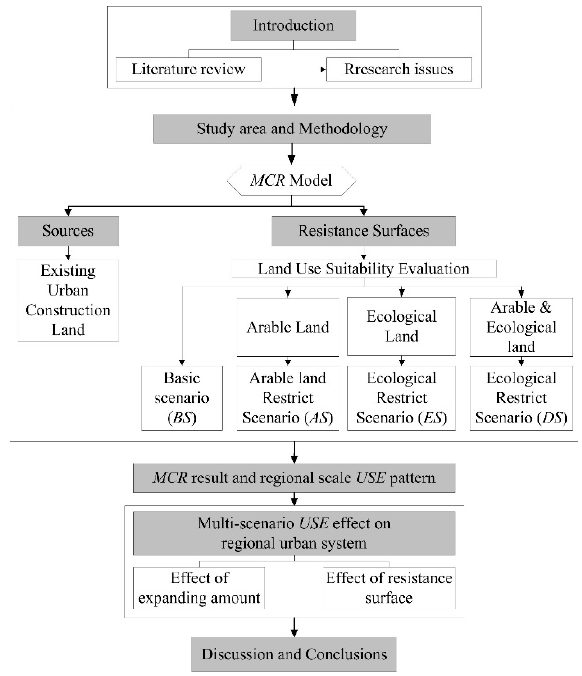
Figure 1. Flowchart of detection